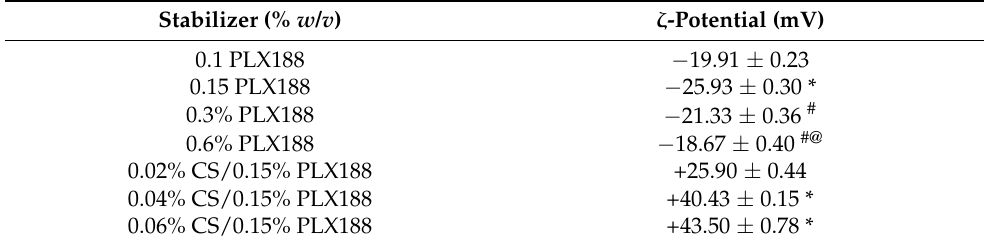
Table 2. ζ -potential of the selected NC